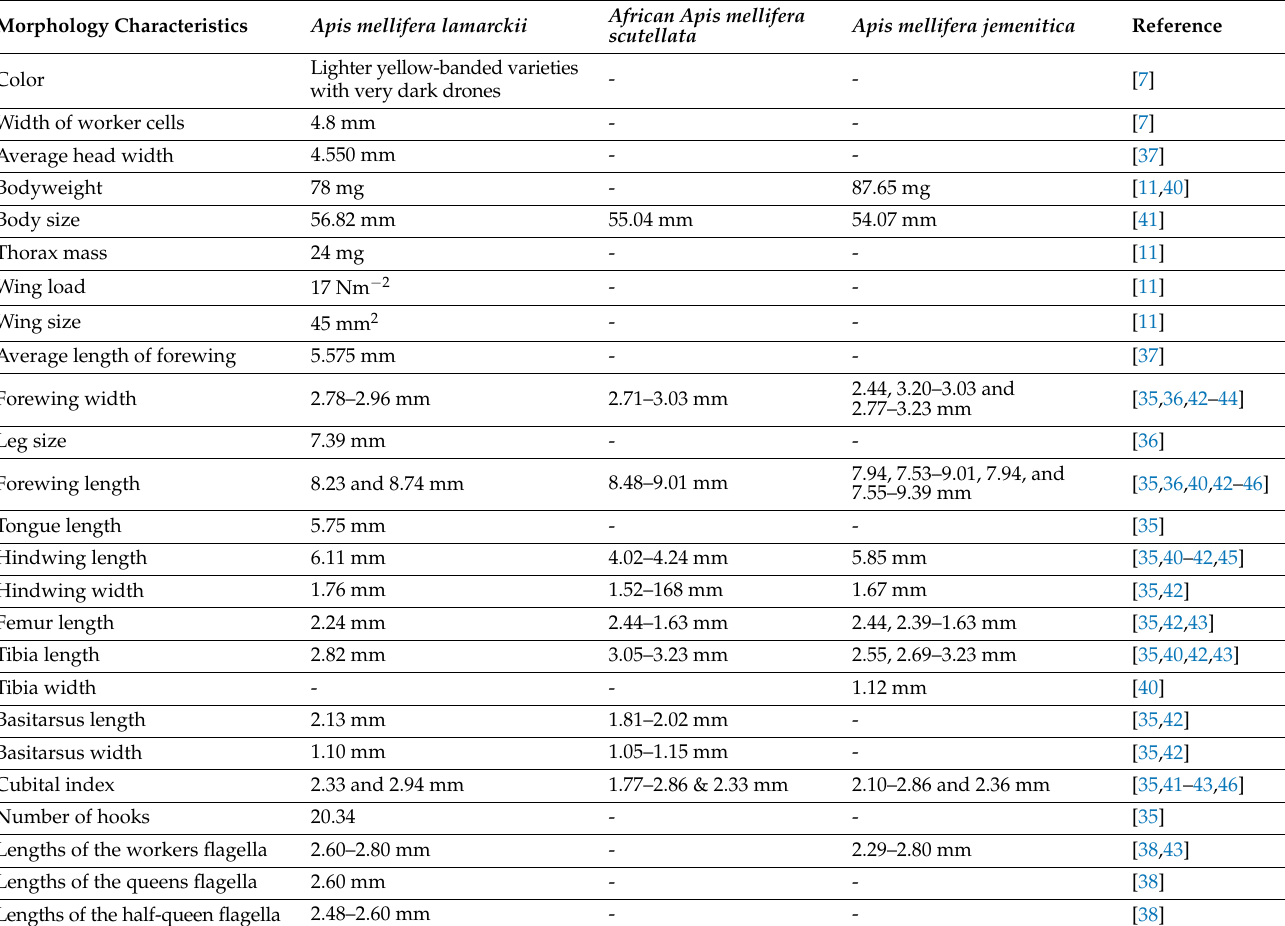
Table 1. Morphological characters of Apis mellifera lamarckii compared to African Apis mellifera scutellata and Apis mellifera jemenitica